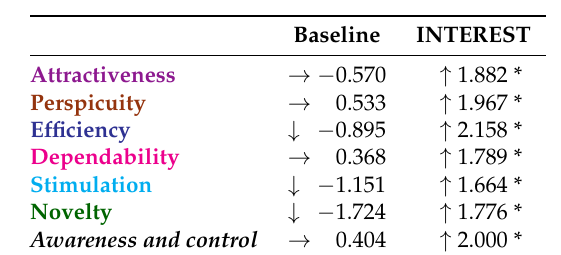
Table 5. Post-task questionnaire results: comparison of Baseline and INTEREST on UX factors. The second and third columns show the mean aggregate rating of each factor. Values are obtained by averaging the ratings given by participants to individual UX aspects: → denotes a neutral value, ↓ a negative one and ↑ a positive one. Significance is encoded as (*) p <